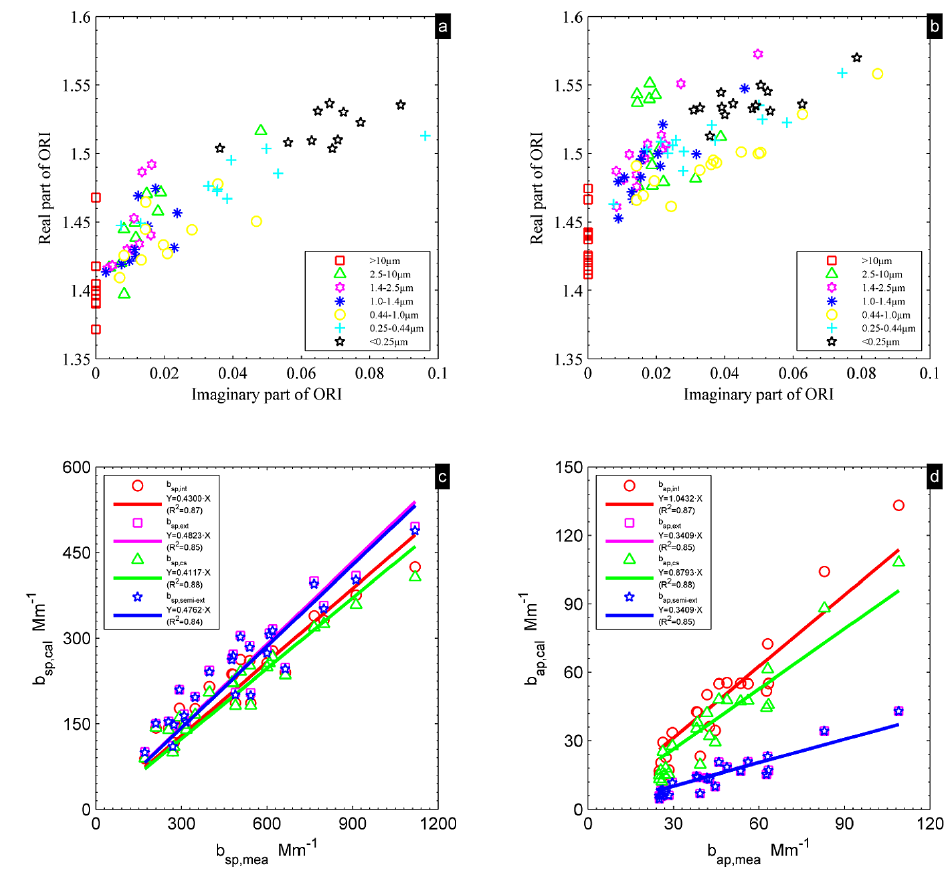
Figure 4. The imaginary part versus the real part of the optical refractive index in the wet (a) and dry (b) season, Mie-model-calculated b sp of mixed particles versus visibility-derived b sp (c) , and Mie-model-calculated b ap of mixed particles versus aethalometer-derived b ap (d) .